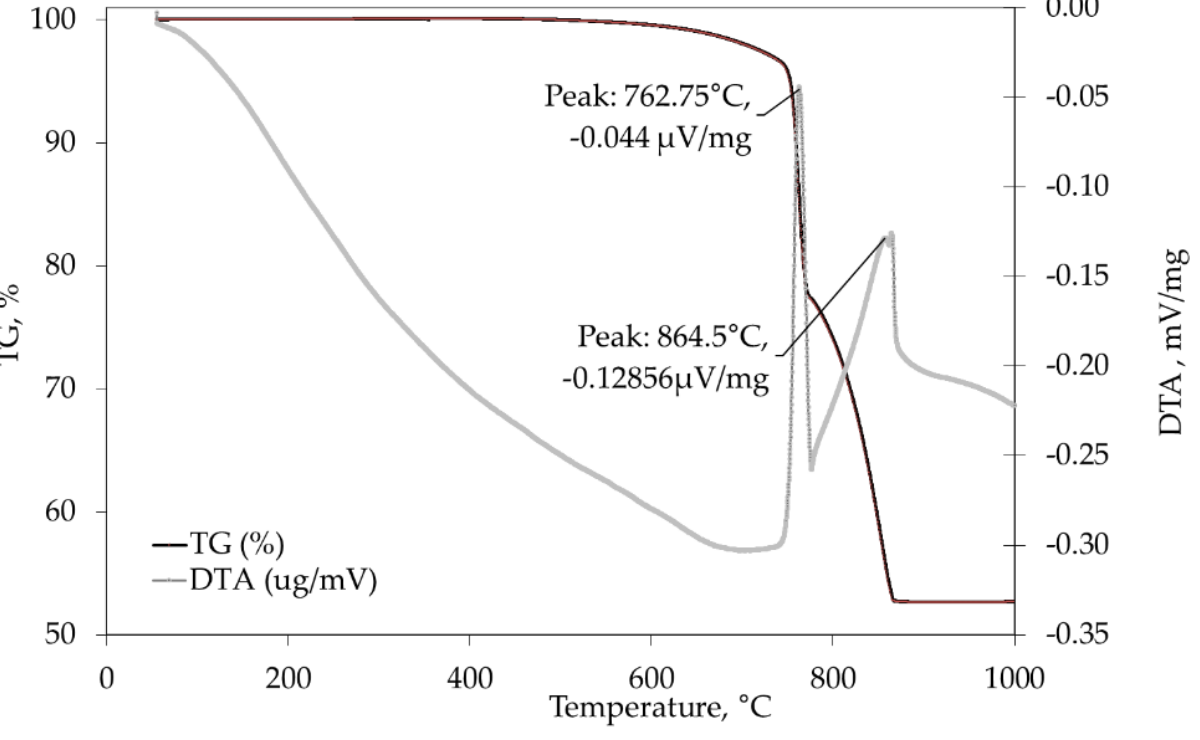
Figure 1. Granulometry of the ( a ) binder materials and dolomite filer, ( b ) aggregate.